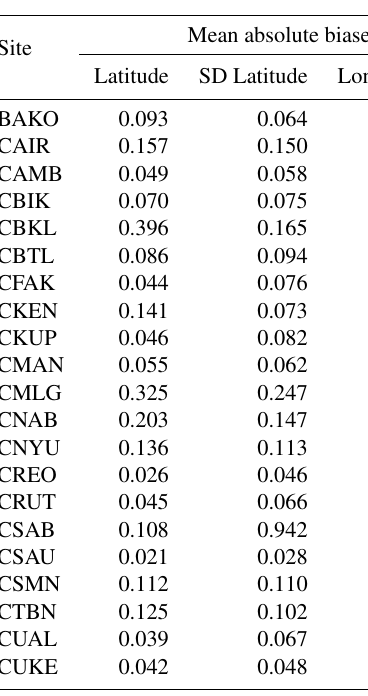
Figure 6. The differences of tropospheric parameters from VMF3 and VMF1. Zenith wet delays and gradients (north and south) were estimated. Table 1. Mean absolute biases and standard deviations for VMF3 and